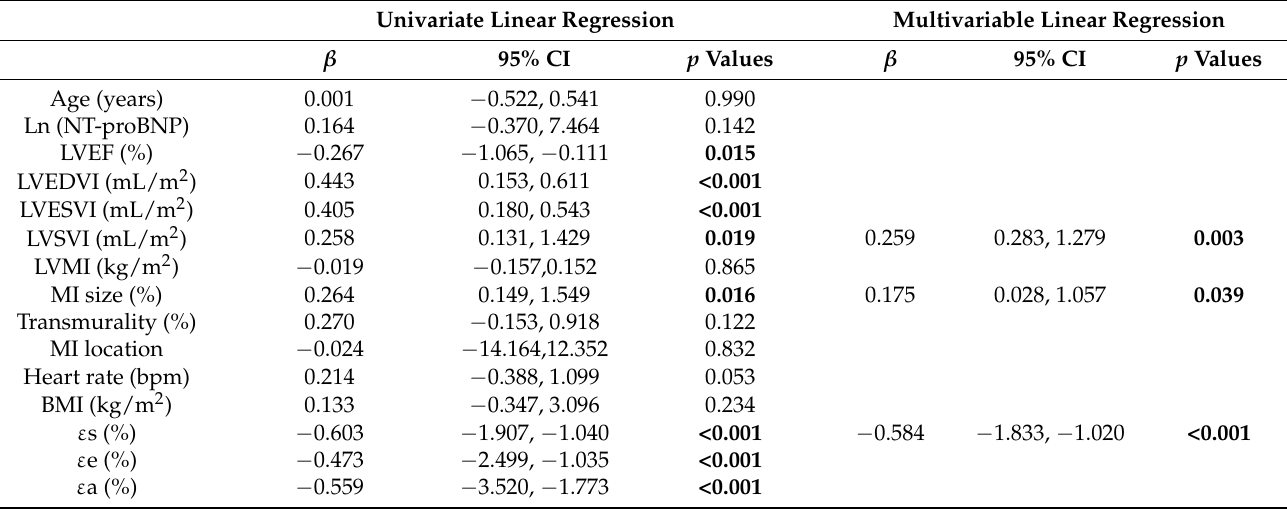
Table 6. Univariate and multivariate regression analysis (backward stepwise) of association with LAVI pre-a (R 2 = 0.445).